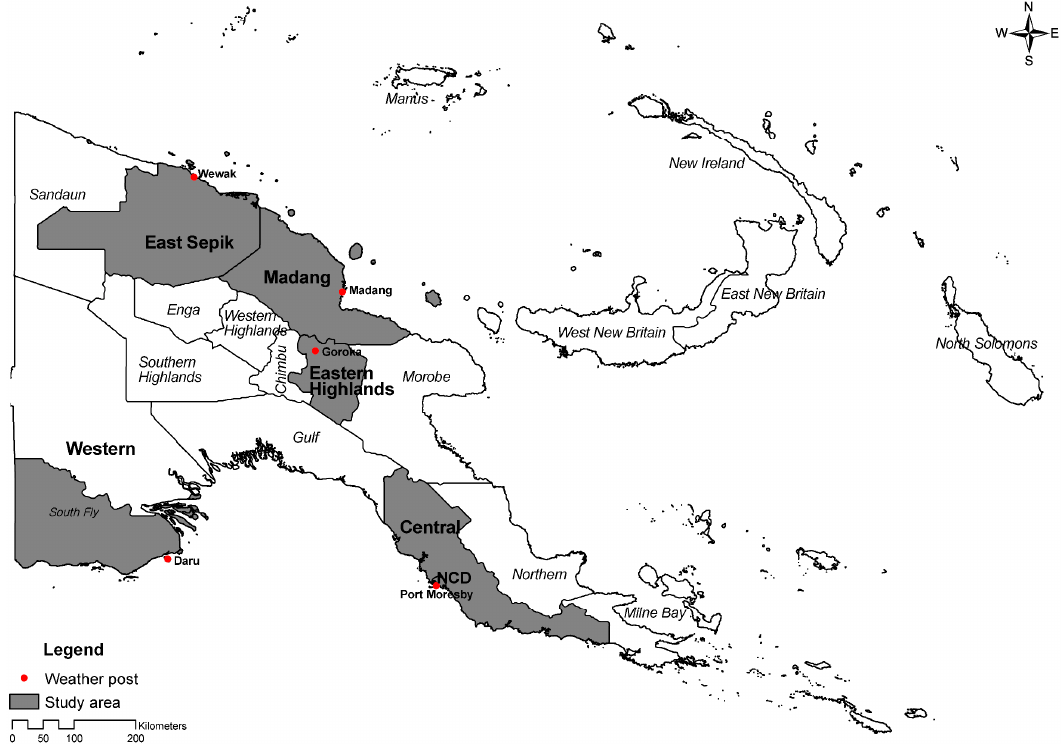
Figure 1. Map of the study areas in Papua New